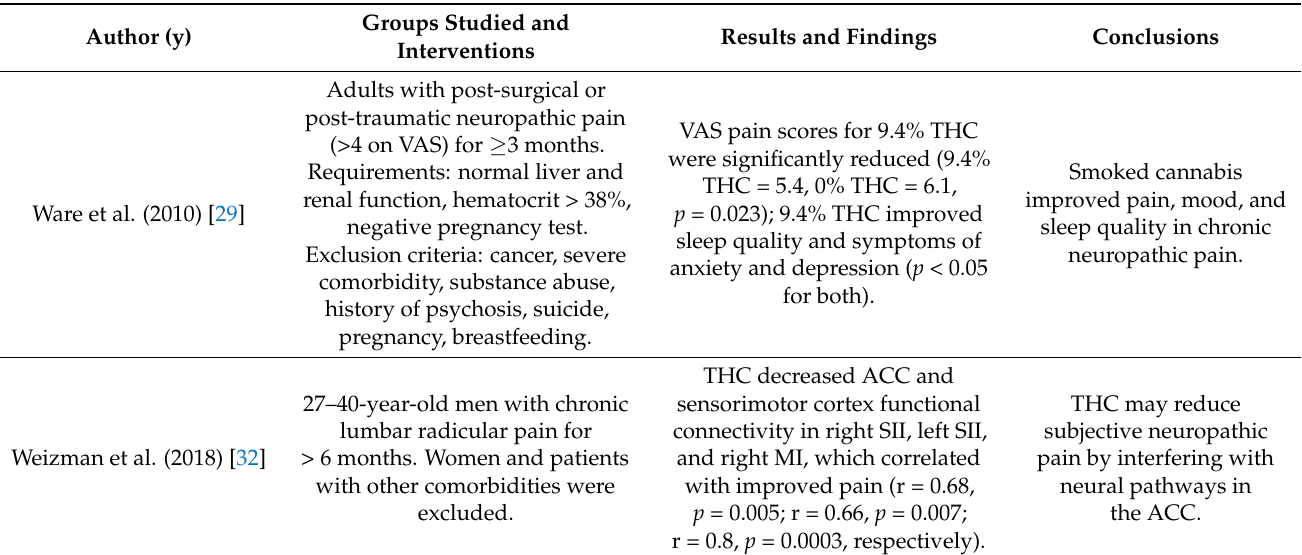
Table 2. Summary of the use of cannabinoids on neuropathic or pain or pain related to chronic pain diseases such as fibromyalgia or